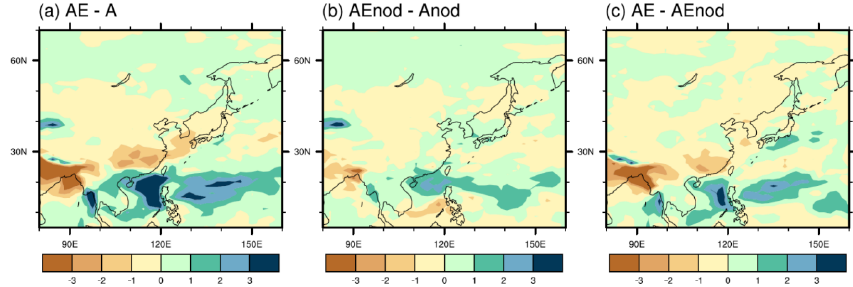
Figure 5. Precipitation differences (mmday − 1 ) in JJA for (a) AE − A (b) AEnod − Anod and (c) AE −